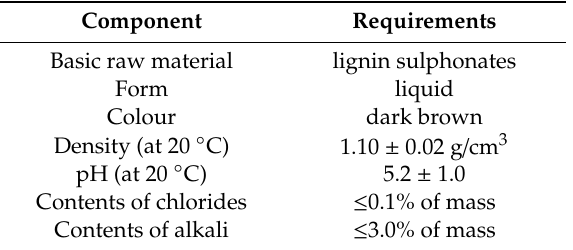
Table 6. Physical and chemical properties of the Master Pozzolith